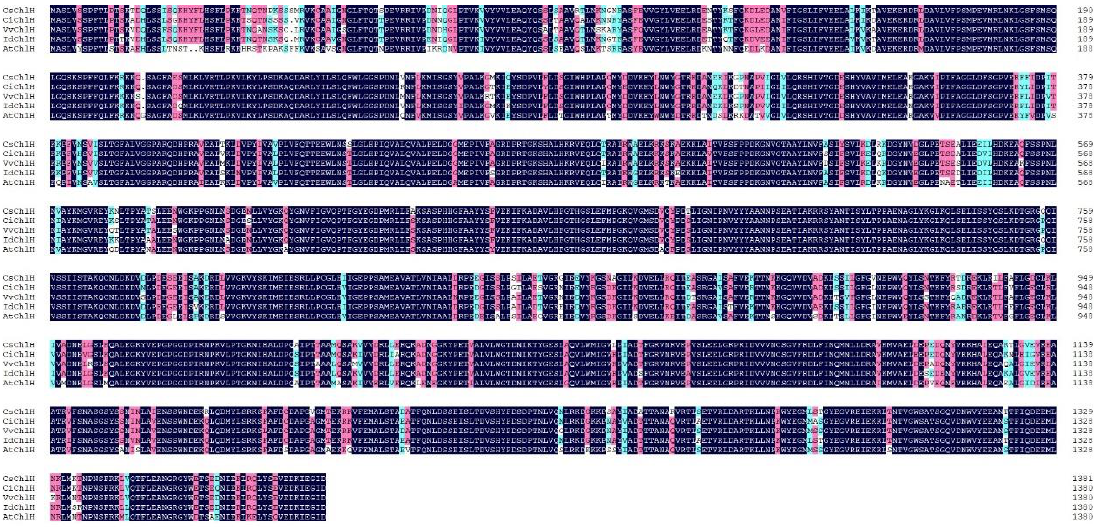
Figure 1. Alignment of the putative amino acid sequence of IdChlH with homologous proteins.